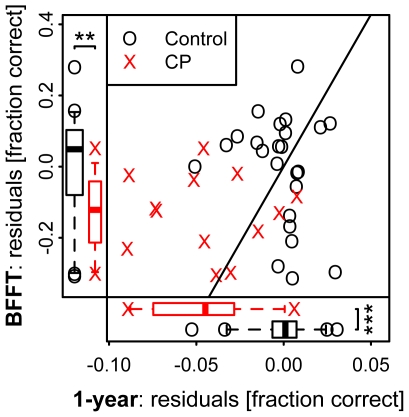
Comparison of famous face test (BFFT) and one-year recognition memory.Overall differences between CPs (X) and controls (O) are more pronounced in the test of one-year recognition memory than in the BFFT. Among controls the test results seem dissociated, with participants scoring bad in either of the two tests but not in both. Several controls who scored low in the BFFT, but all of them show normal performance in the standardized one-year recognition memory test.